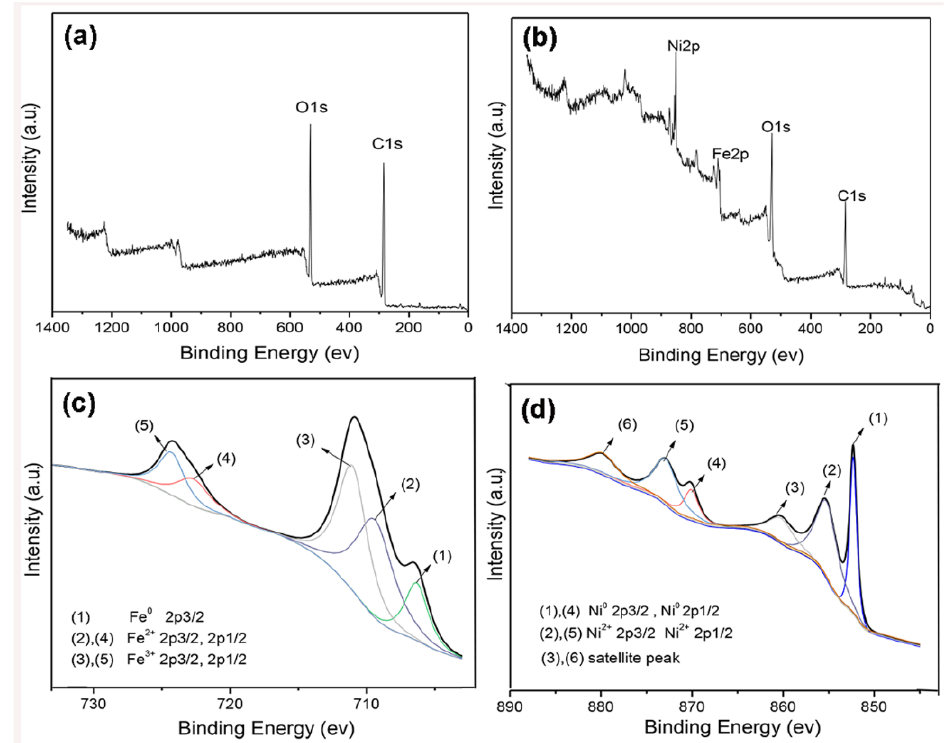
Figure 6. X-ray photoelectron spectroscopy (XPS) spectra of unmodified wood and MW–18 wt %. ( a ) Unmodified wood, ( b ) MW–18 wt %, ( c ) XPS spectrum of Fe 2p and ( d ) XPS spectrum of Ni